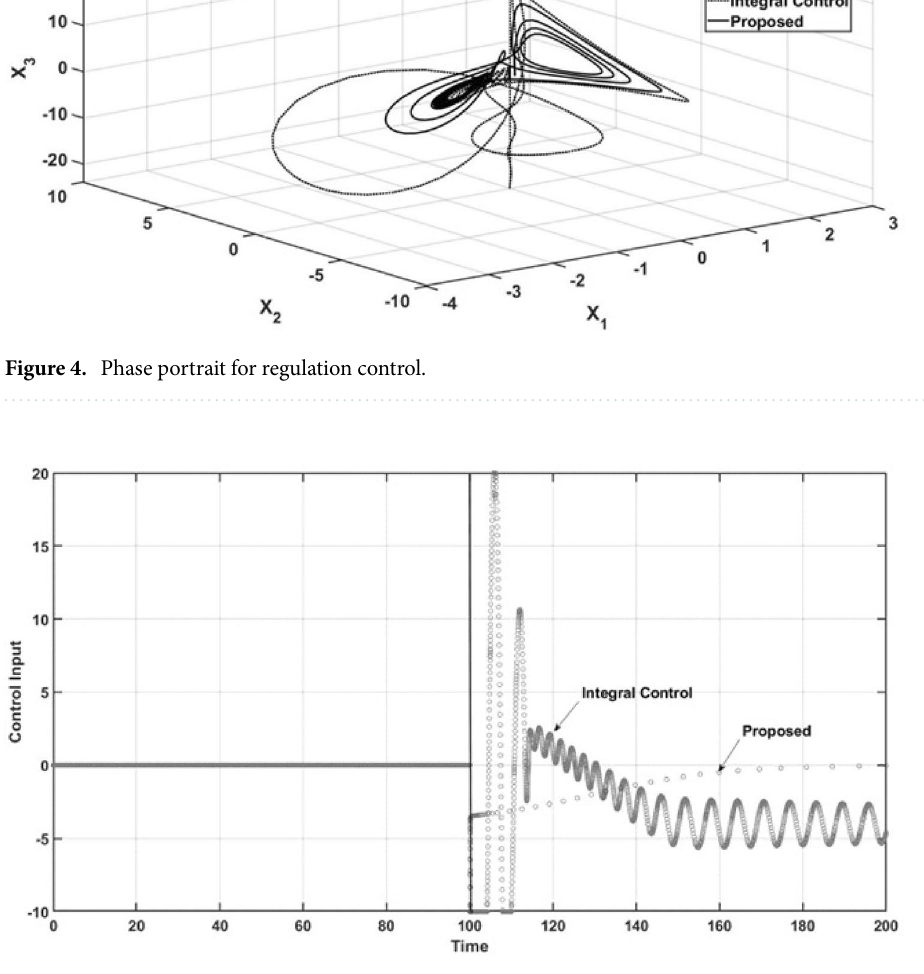
Figure 5. Control signals impacted by the regulation